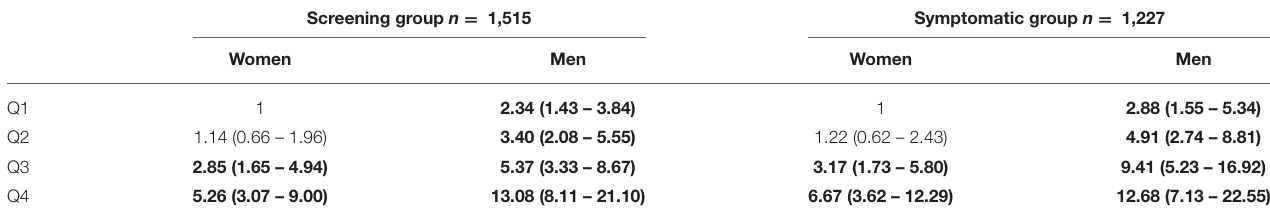
TABLE 5A | Risk of advanced neoplasia according to sex and hemoglobin quartile. Screening group n = 1,515